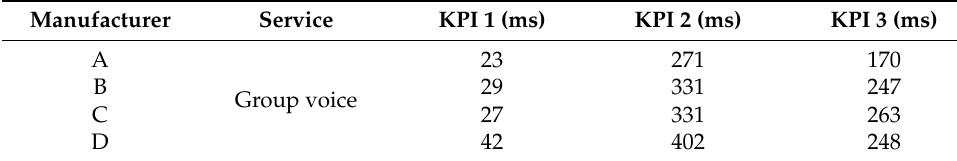
Figure 6. Test composition for KPI. Table 4. Test results of MCPTT for KPI 1/2/3.